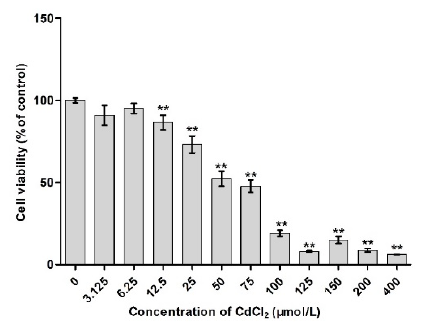
Figure 1. Effect of Cd on the activity of TM4 cells. ** p < 0.01 as compared to the control group.